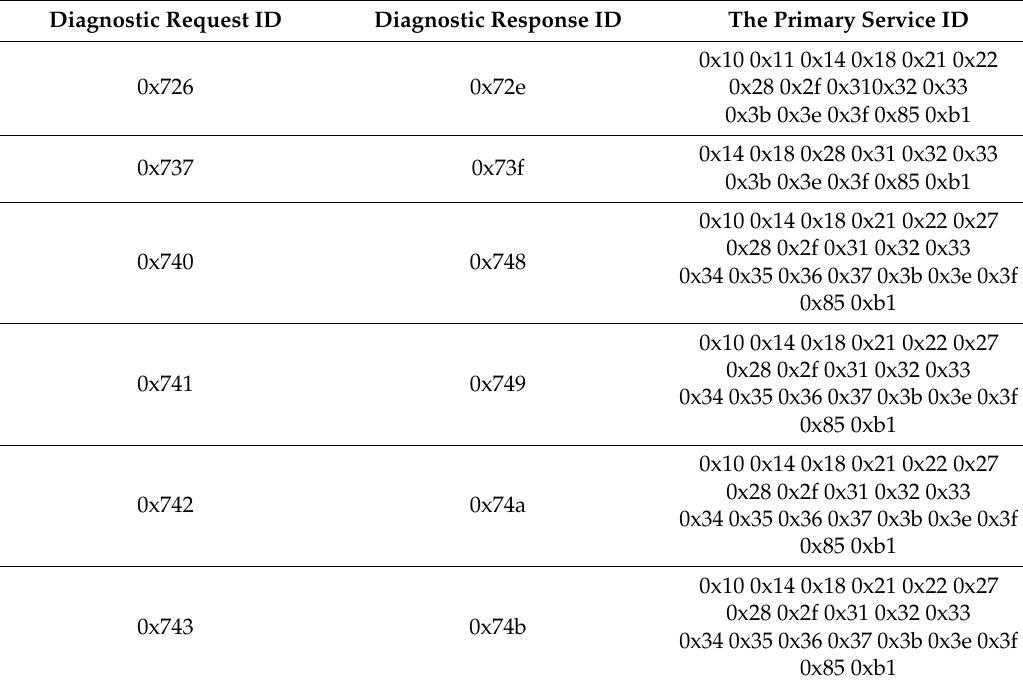
Table 5. Diagnostic services of the Ford